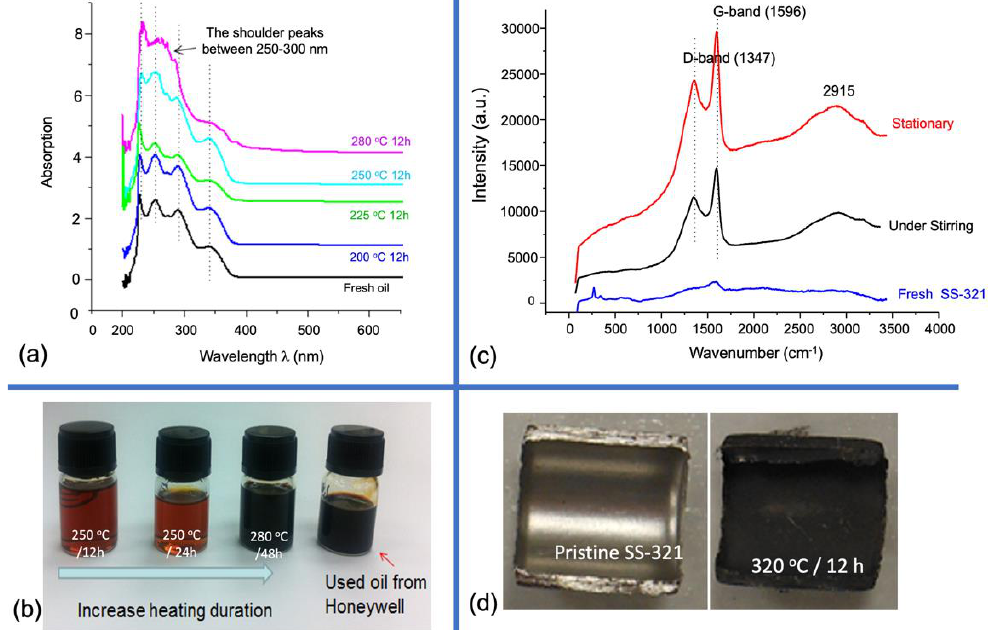
Figure 3. ( a ) The UV – Vis spectra of the aerospace lubricant samples (diluted in ethanol 10 −3 v / v ). The lubricants were treated in small glass jugs with different heating histories. ( b ) The photos of the oil samples show increasing thermal decomposition extent, in which the used lubricant oil was collected from the circulating pipe of an aircraft engine system as the reference. ( c ) Raman spectra of the inner surfaces after a new SS-321 tube were immersed in the lubricant at 320 °C for 12 h with and without stirring. ( d ) Photos of the pristine SS-321 and the stationary sample.